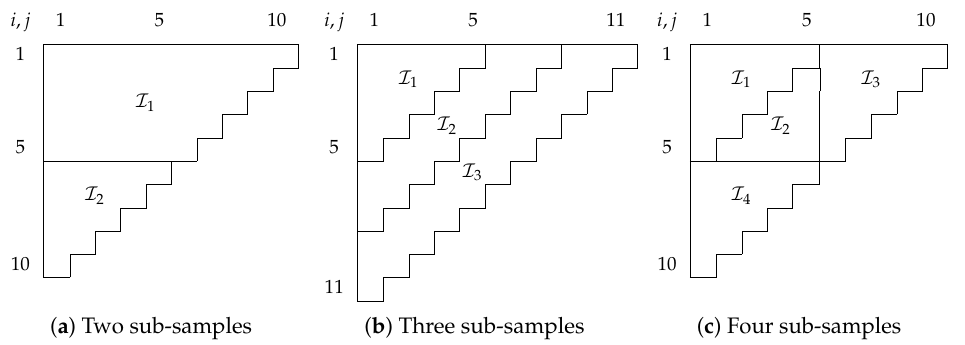
Figure 1. Examples for splits of run-off triangles into two ( a ), three ( b ) and four ( c ) sub-samples. Sub-samples are denoted by I (cid:96) . Accident years i are in the rows, development years j in the